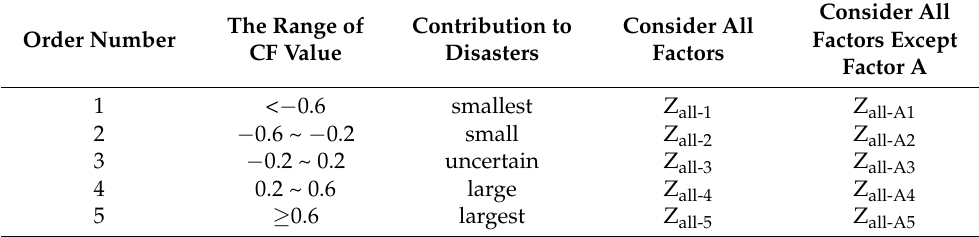
Table 1. Division of CF